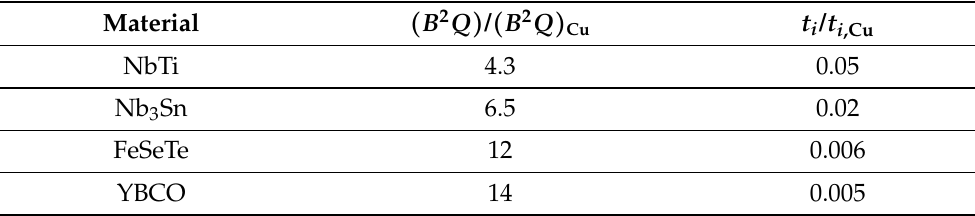
Table 3. Comparison of the ( B 2 Q ) figure of merit of the different materials, with respect to that of Cu at 5 T, 4 K, 9.08 GHz.